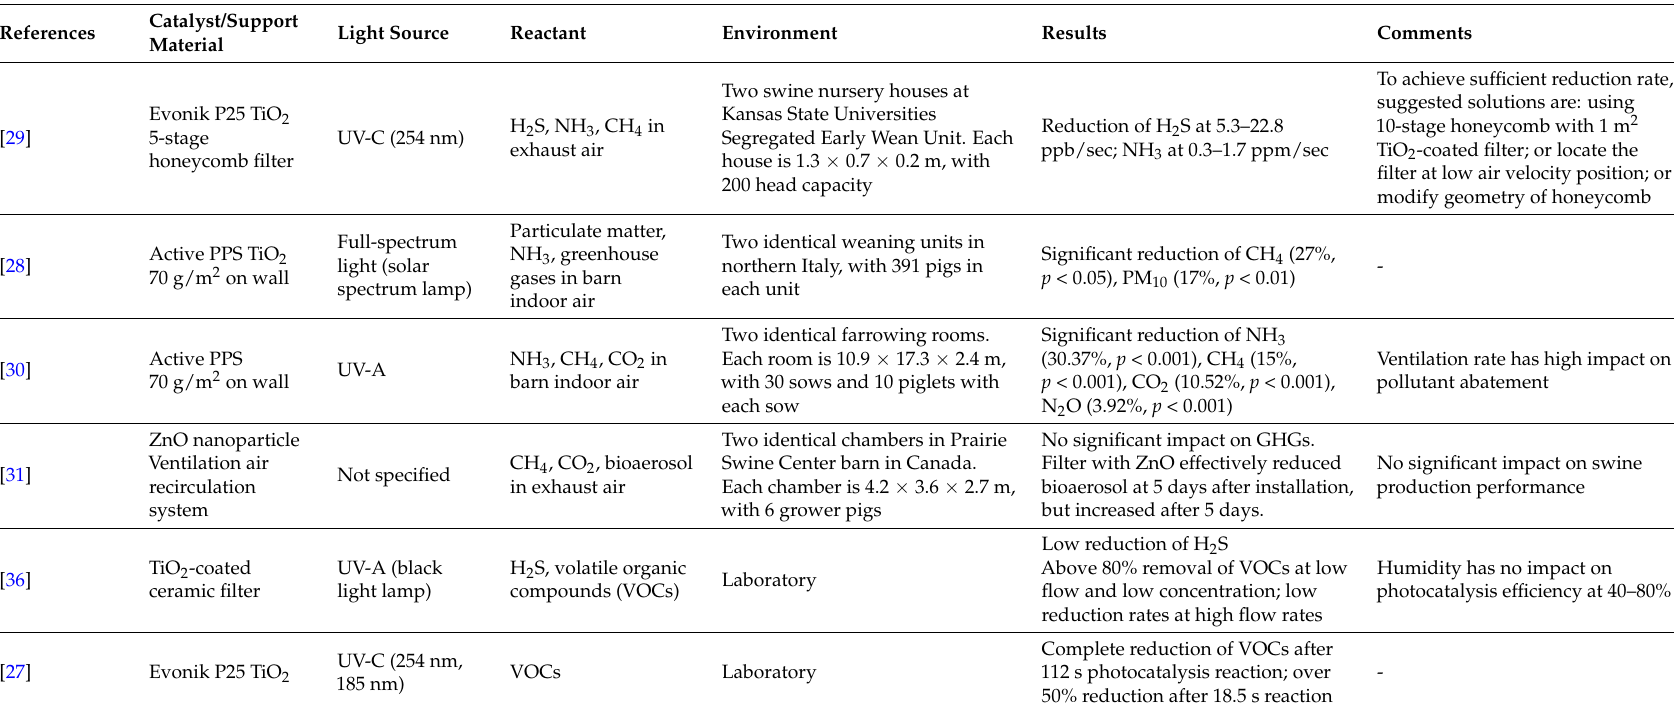
Table 1. Summary of the application of photocatalysis for swine barn emission